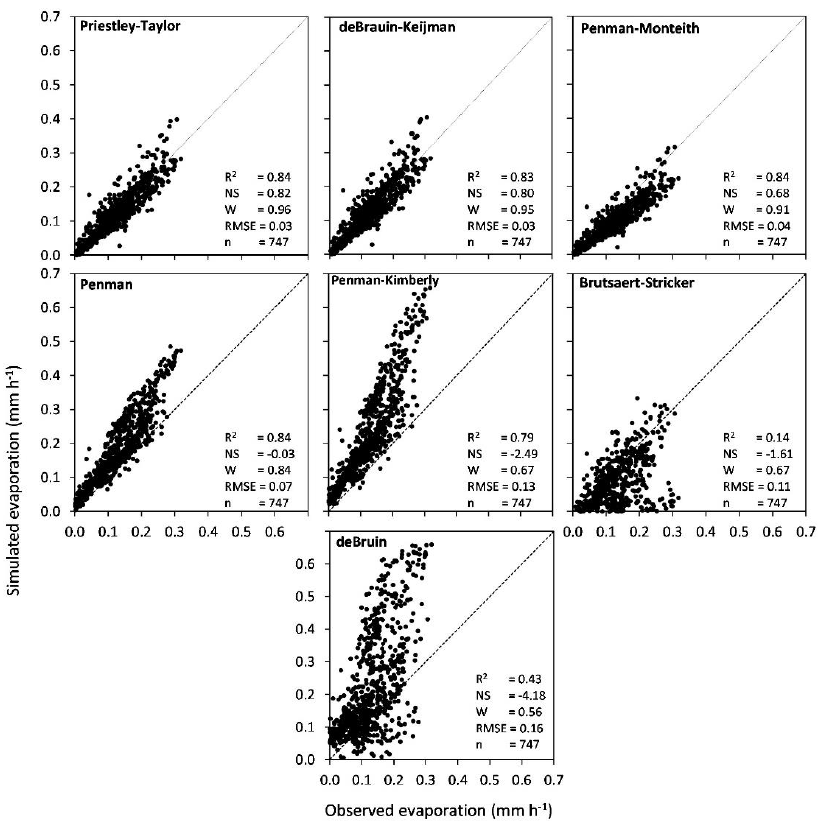
Figure 8. Relationship between hourly measurements of evaporation and model estimation with the combination model group (root mean square error (RMSE) in mm h −1 )).